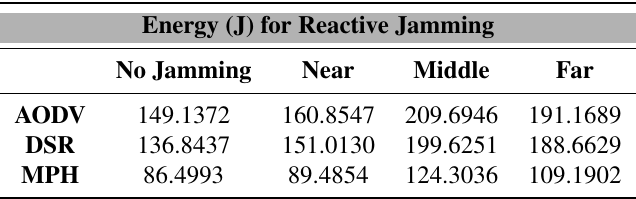
Table 9. Sum of values of the total energy for Figure 11.